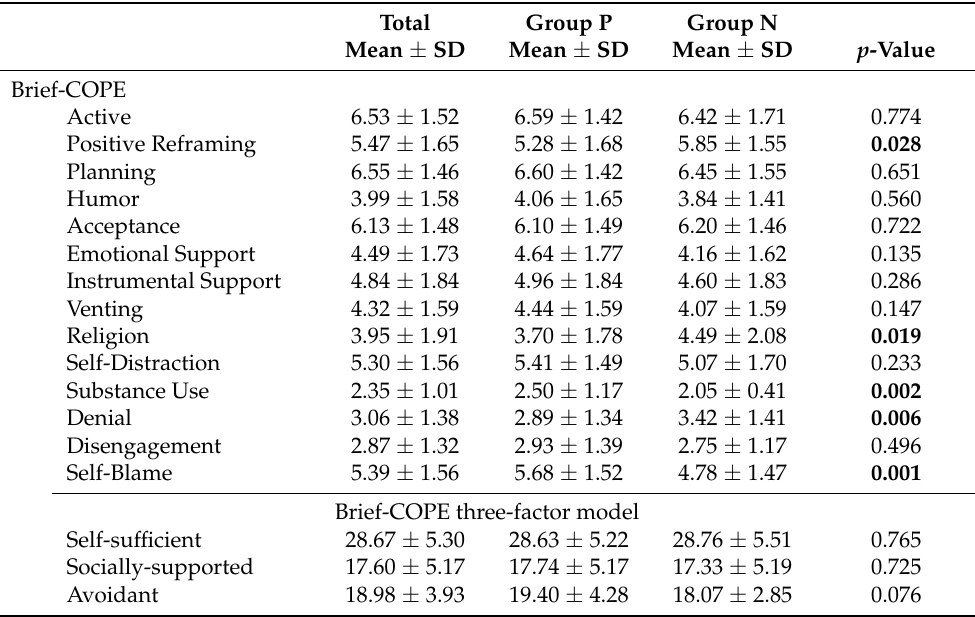
Table 5. Mean scores of Brief-COPE during the first wave of the COVID-19 pandemic (n =